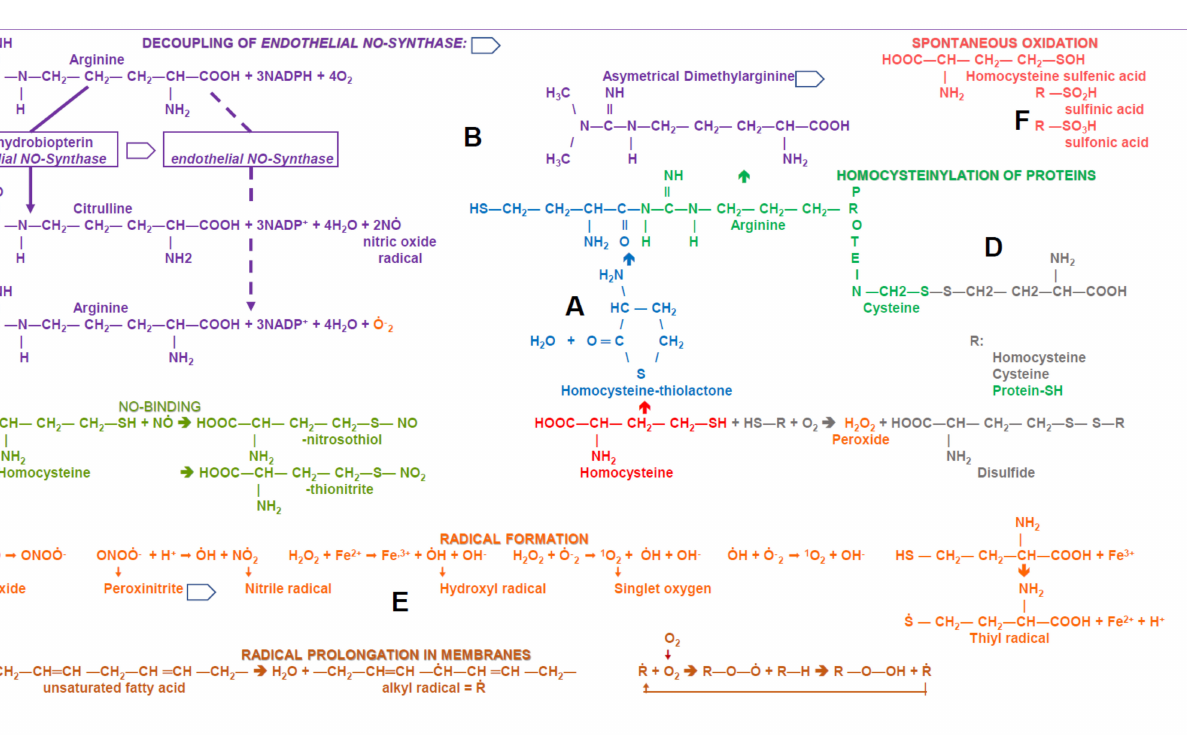
Figure 4. Homocysteine pathology; presentation of the most important possible reactions of HCys resulting in pathological effects; color differentiation and capital letters allow assignment to the different mechanisms and their effects: ( A ) In contrast to cysteine, HCys has a highly reactive sulfhydryl group, e.g., it can form a ring shape in the case of homocysteine thiolactone, which accounts for approximately 1/10 of the free HCys in blood plasma and can bind to lysine or arginine residues of proteins via a peptide bond (N-homocysteinylation) [55]. ( B ) In the latter case, asymmetrical dimethylarginine is released during the destruction of the protein, which decouples the endothelial nitric oxide (NO) synthase, so that it produces the superoxide anion instead of NO [56]. NO and the superoxide anion form peroxynitrite, which further contributes to decoupling of the enzyme complex [56]. ( C ) HCys itself can bind NO and thus inactivate it [57]. ( D ) HCys forms mixed disulfides with cysteine residues of proteins, called S-homocysteinylation, which can lead to functional impairments [58]. ( E ) HCys generates hydrogen peroxide via disulfide formation, from which all important ROS and radicals can arise [59]. ( F ) The spontaneous oxidation of the sulfhydryl group results in homocysteic acid (homocysteine sulfonic acid) with an agonistic effect on N-methyl-D-aspartate (NMDA) receptors